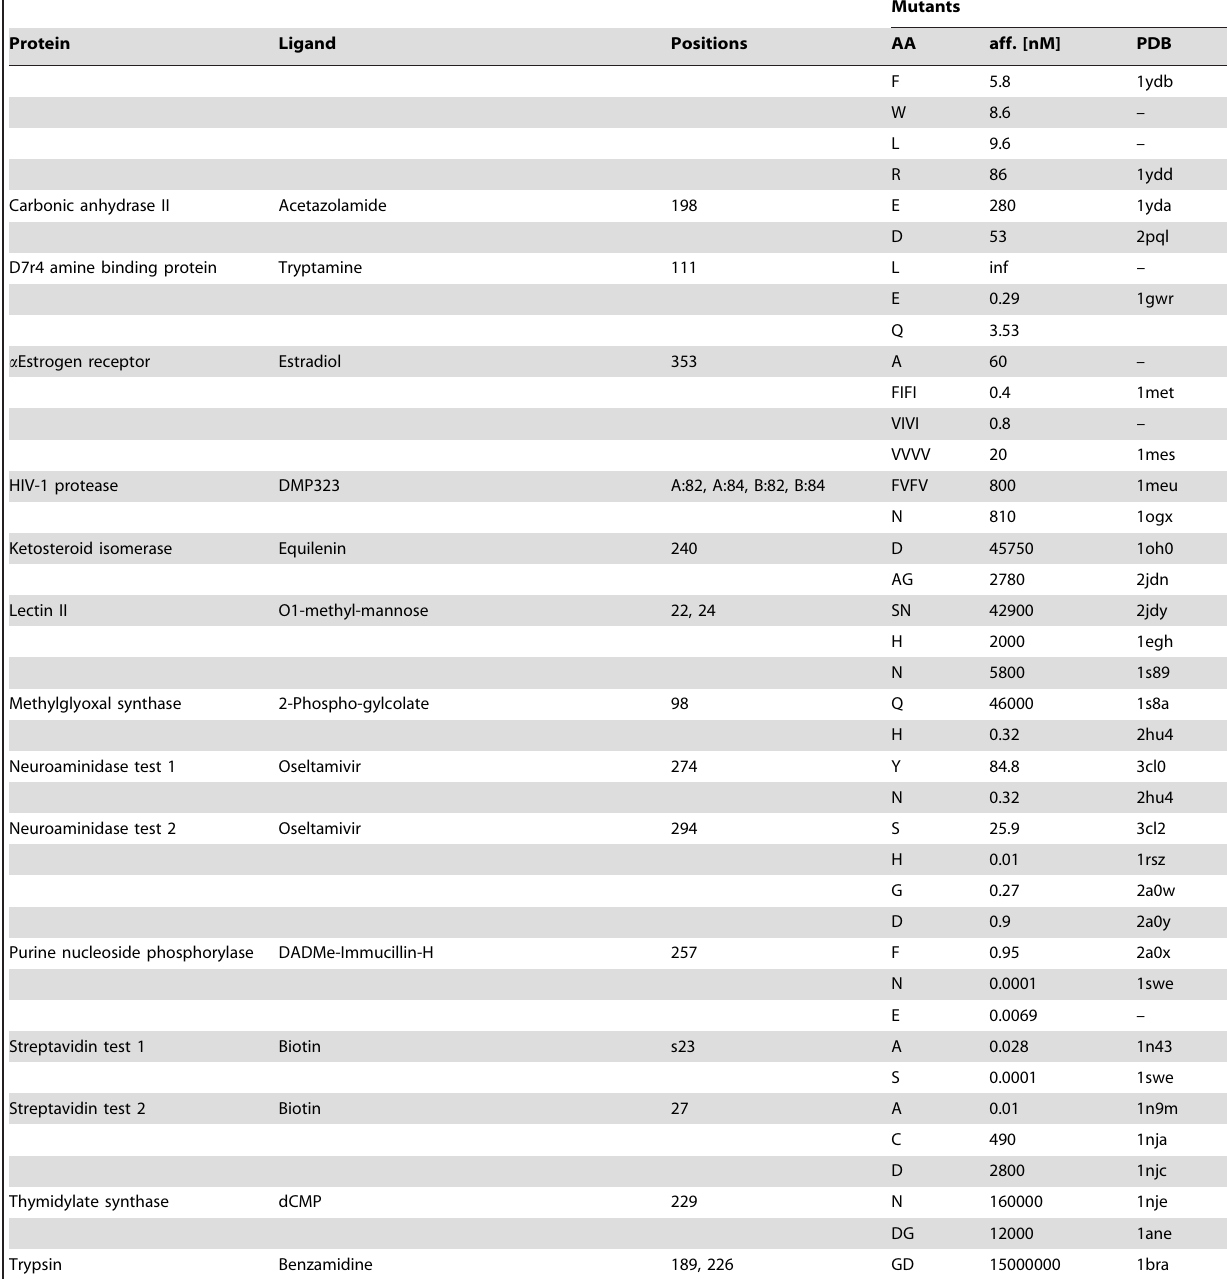
Each row lists a test case. Columns Protein and Ligand contain the name of protein or ligand, Positions the indices of the mutable positions (for HIV protease along with the chain identifier, in the other cases the pocket is formed by one chain only), Mutants lists the variants: in subcolumn AA the amino acids at the mutable positions, in aff. the affinities of the variants, and in PDB the PDB identifier of the corresponding crystal structure, should one exist. Figure 4: the lines for designs of both P OCKET O PTIMIZER variants, energy term for hydrogen bonds in R OSETTA seems to have less influence on the output than in our program. This causes R OSETTA Vina and CADDSuite, are more similar to each other than the ones for R OSETTA designs. This is rather surprising, as we to miss existing hydrogen bonds between ligand and side chains. The binding scores and their differences predicted for different anticipated that the limited backbone flexibility included in the mutants are more dependent on the scaffold structure used in R OSETTA enzyme design protocol would lead to less dependency Rosetta designs than it is in P OCKET O PTIMIZER . This can be seen in on these small input structure differences.